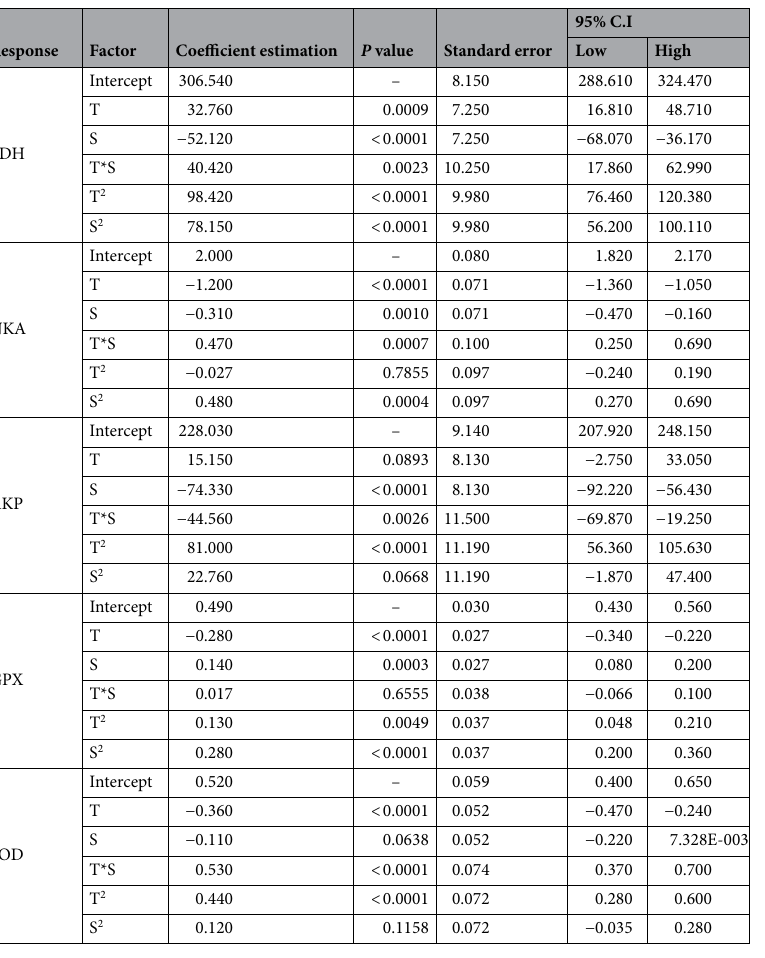
Table 4. Coefficient estimation of the respiratory metabolic index prediction model